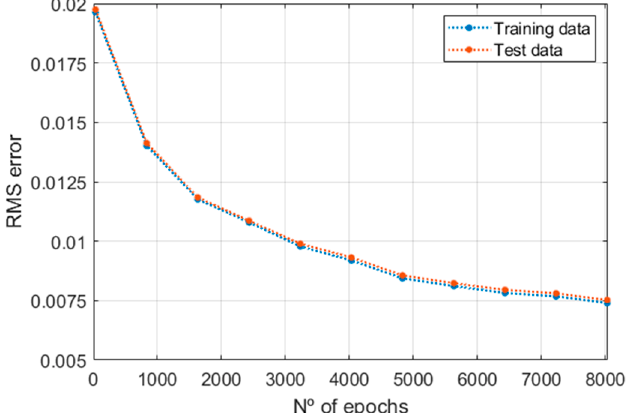
Figure 10. Training and test RMS errors.